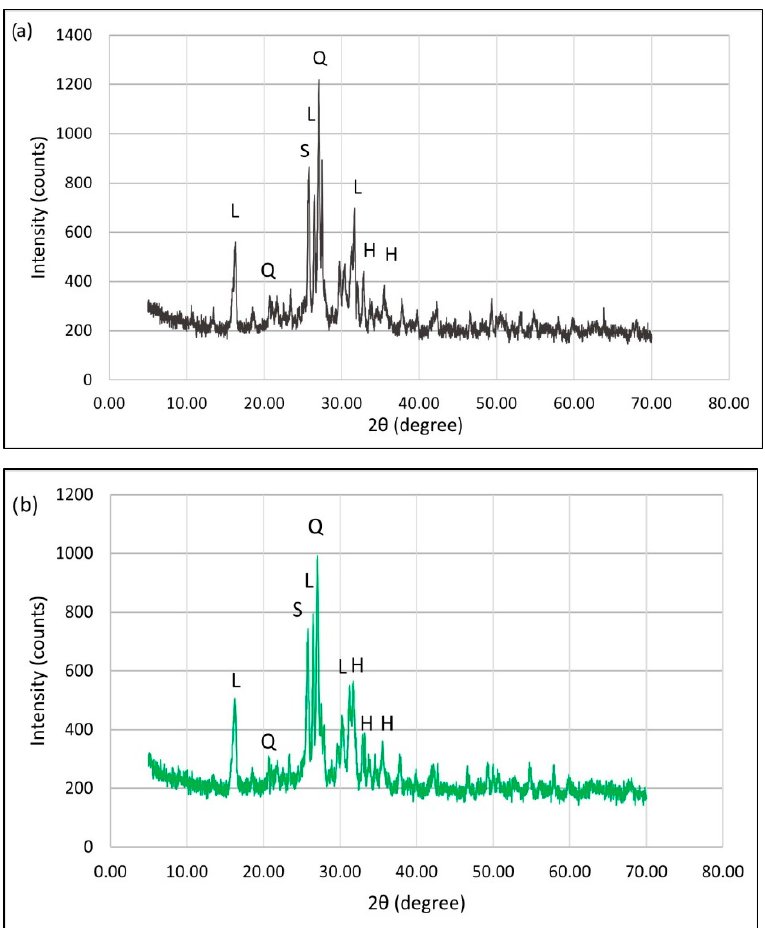
Figure 4. X-ray diffractograms of APNUT ( a ) and APV50 ( b ) (Q = quartz; L = leucite; S = sanidine; H = hydroxyapatite).